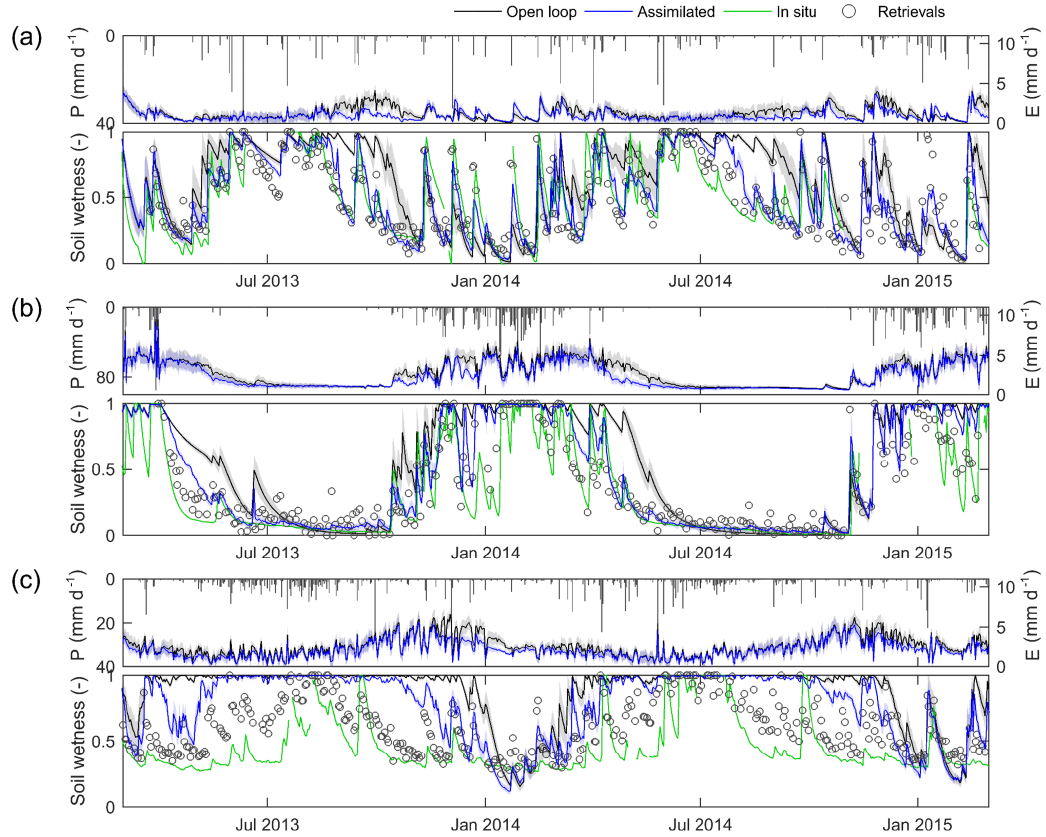
Figure 5. Time series of precipitation forcing and modeled evaporation and top-layer model soil moisture in the open loop (grey line and shading) and after assimilating L-band retrievals (blue line and shading) at sites Y10 (a) , AU-Whr (b) , and AU-DaS (c) . Time series of rescaled L-band retrievals (circles) and field–measured soil moisture (green line) are included for reference. These sites are classified as a grassland, savanna, and evergreen broadleaf forest, respectively. Shaded areas represent the 10th–90th percentiles of the model